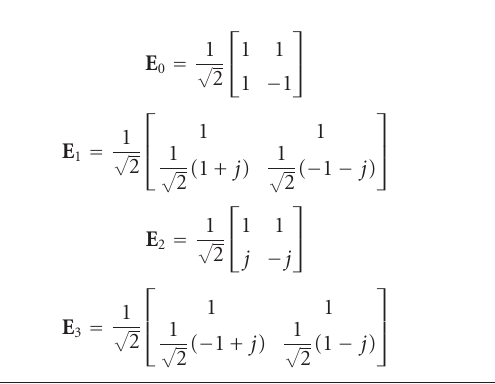
Table 2: Codebook size for unitary precoding, L = 4. Table 3: Feedback overhead for the considered MIMO schemes for L = 2, Q =